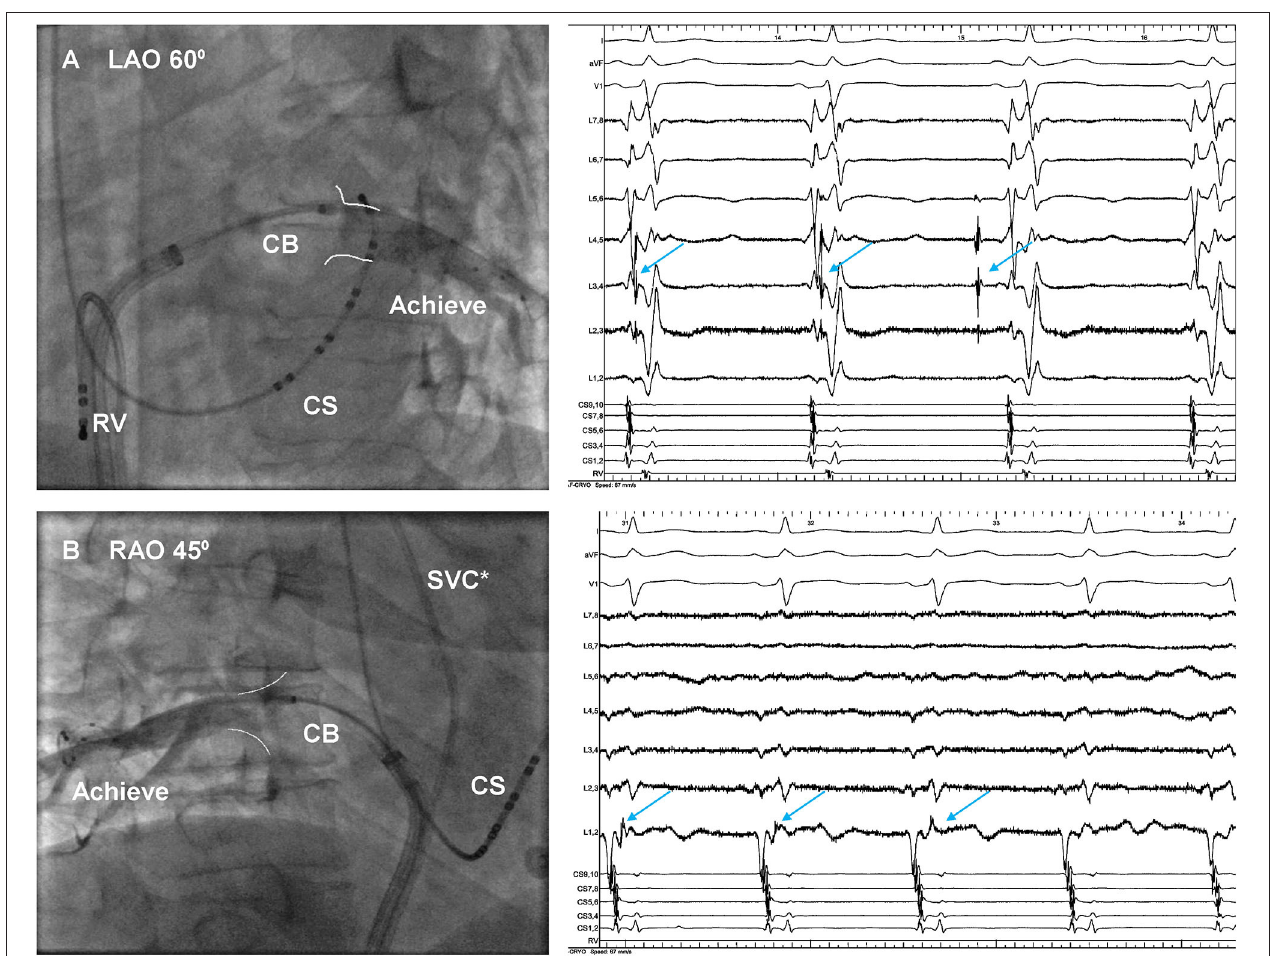
FIGURE 3 | Venography of inferior pulmonary veins during cryoballoon (CB) ablation. The 28-mm CB was positioned at (A) ostium of the left inferior pulmonary vein and (B) ostium of the right inferior pulmonary vein. The conduction of PVPs (arrow) was delayed and then blocked. *The quadripolar catheter was placed within SVC. CS, coronary sinus; RV, right ventricle; SVC, superior vena cava; PVPs, pulmonary vein potentials.